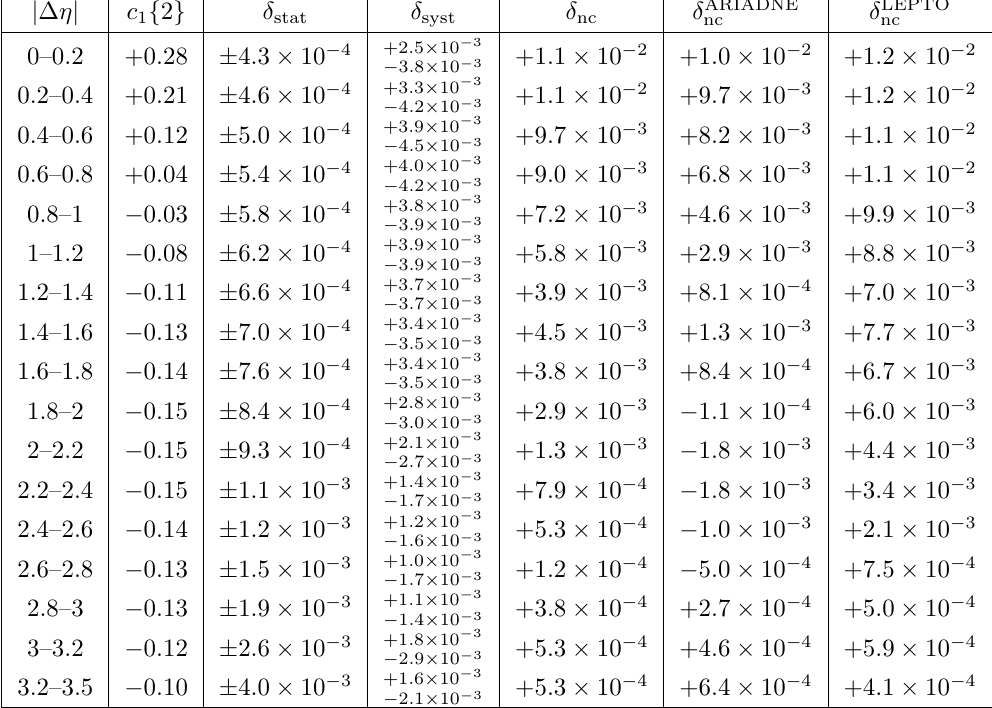
Table 14 . c 1 f 2 g versus j (cid:1) (cid:17) j from (cid:12)gure 8 (a) and (cid:12)gure 11 (c), p T > 0 : 5 GeV; (cid:14) stat , (cid:14) syst and (cid:14) nc denote the statistical, systematic and Monte Carlo non-closure uncertainties,